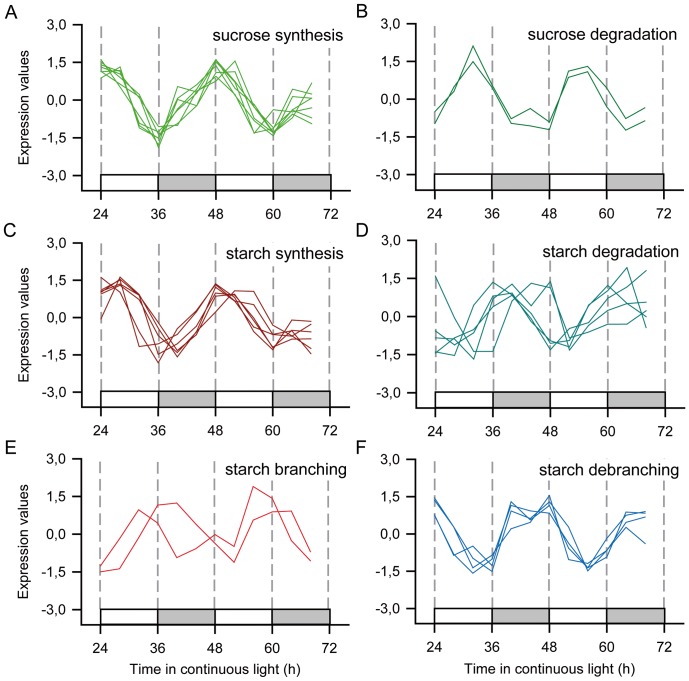
Rhythmic probes associated with sugar storage.Z-score normalized time courses of rhythmic probes for transcripts associated with sugar storage pathways were separated into (A) sucrose synthesis (light green); (B) sucrose degradation (dark green); (C) starch synthesis (dark red); (D) starch degradation (cyan); (E) starch branching (red); and starch debranching (light blue). White boxes represent periods of subjective day and light grey boxes represent periods of subjective night.